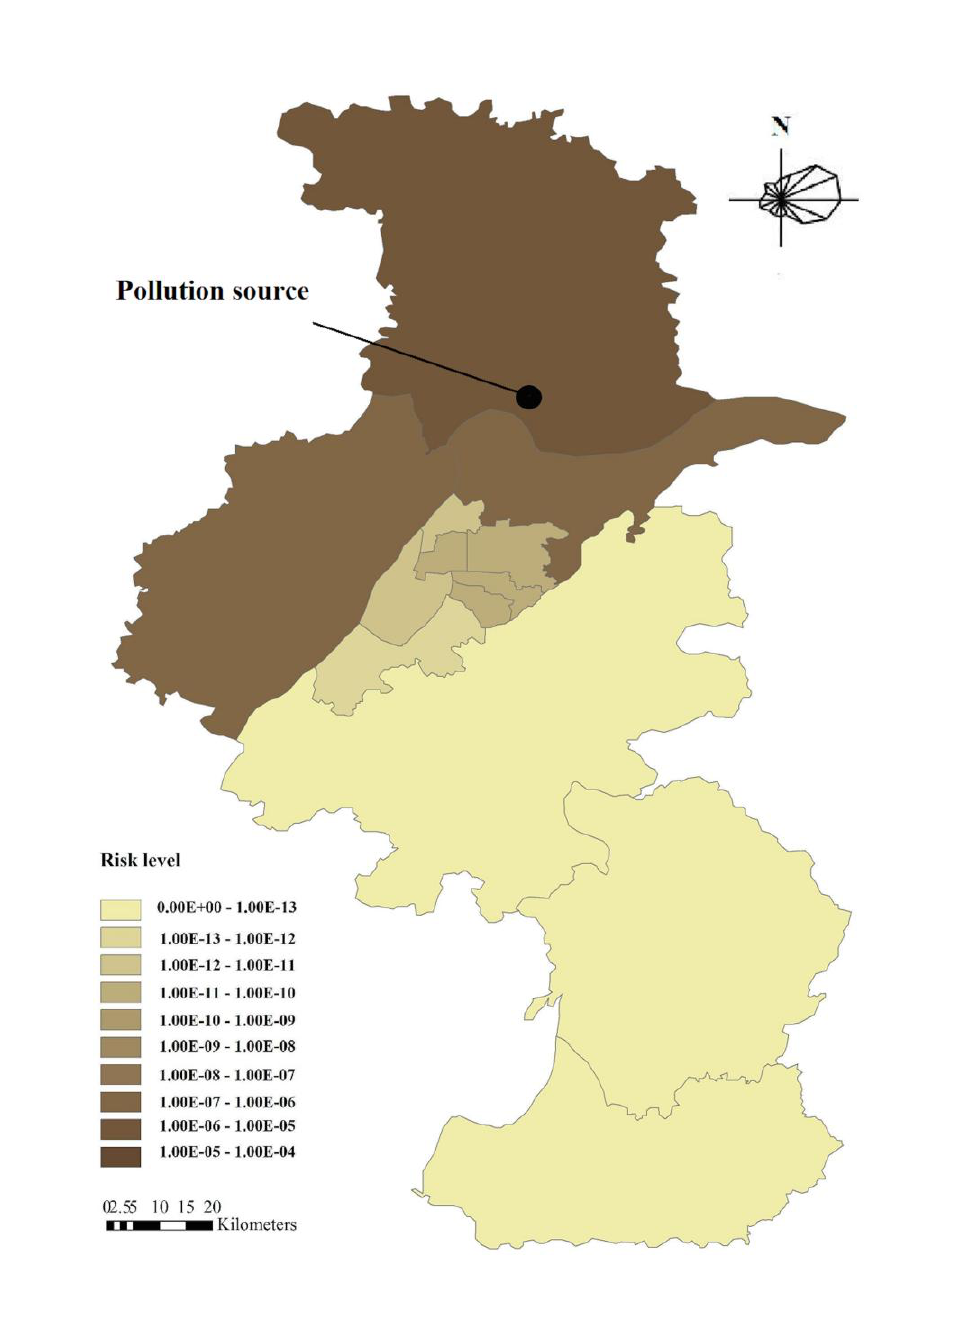
Figure 4. The spatial distribution of the cancer risk induced by industrial BaP in Nanjing in 2006 with east